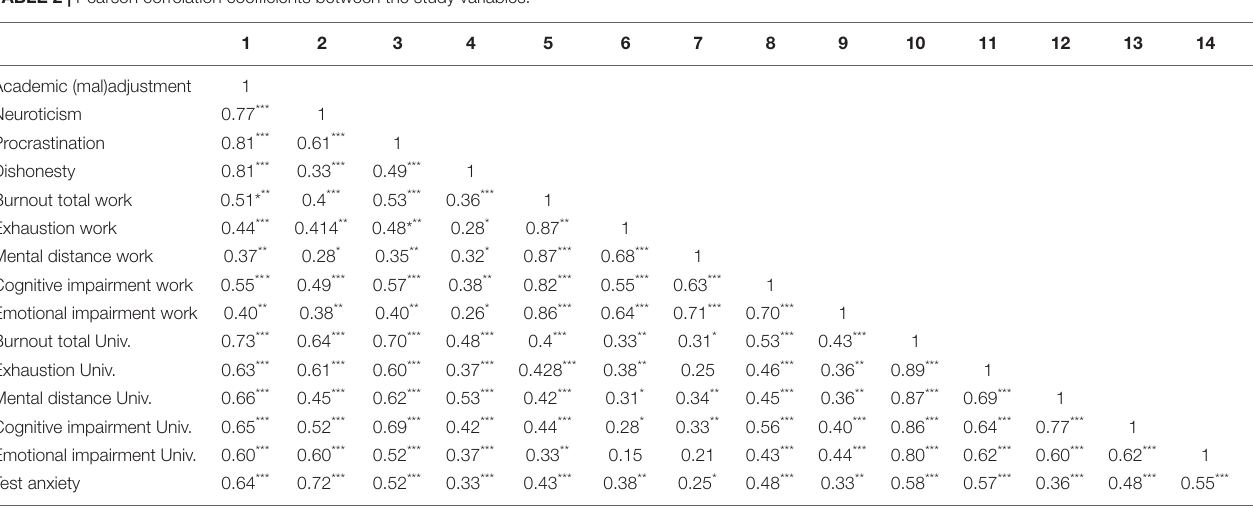
FIGURE 1 | Moderation model of relationship between burnout and academic maladjustment (moderator: occupational status). Note: n.s. = not significant, * p < 0.05, ** p < 0.01. TABLE 2 | Pearson correlation coefficients between the study